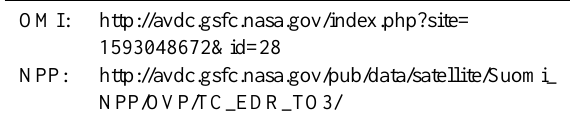
Table 4. Location of OMI and NPP overpass data